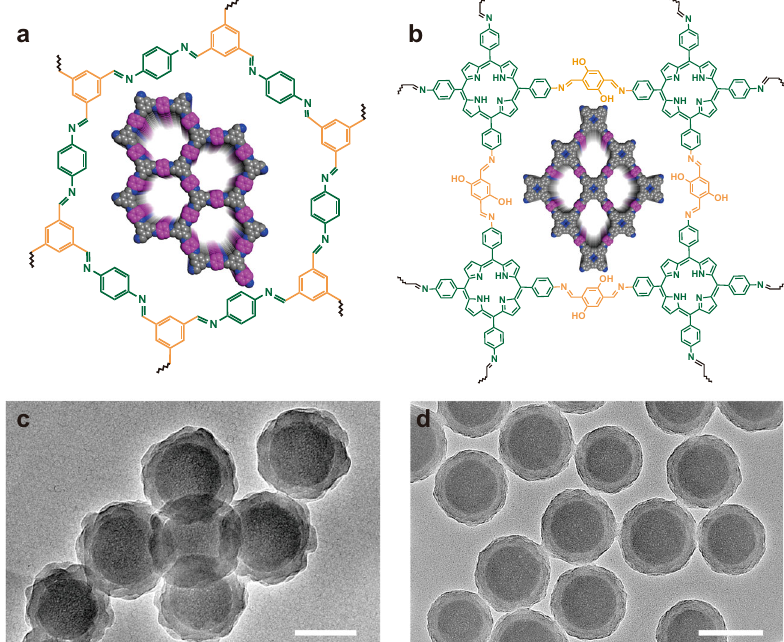
Fig. 3 Dual-ligand assistant strategy for growing LZU-1 and porphyrin-based COF-coated SiO 2 . Structural unit and (inset) space fi lling model of ( a ) LZU- 1 and ( b ) porphyrin-based COF. TEM images of the core@shell structured ( c ) SiO 2 @LZU-1, and ( d ) SiO 2 @porphyrin-COF nanocomposites. Scare bars are 100 nm in ( c ) and 200 nm in ( d ). A representative image of three replicates from each group is